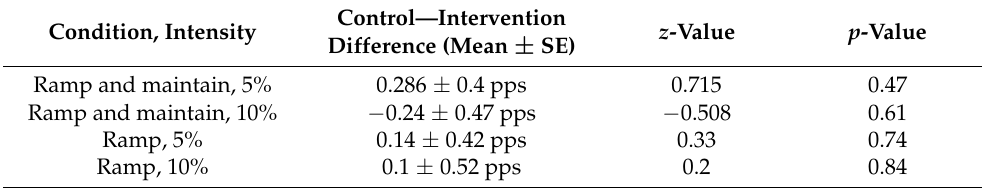
Table 4. Estimated group differences in the average peak firing rate (PFR) of MUs across groups. Condition,